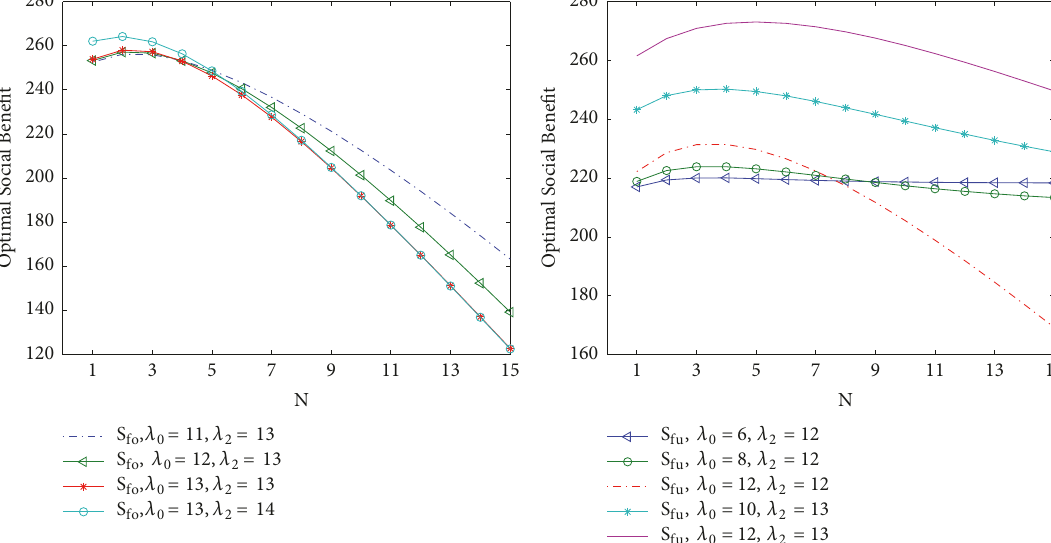
Figure 8: Left: optimal social benefit in observable case vs. 𝑁 for 𝑅 = 30, 𝐶 1 = 10, 𝐶 2 = 10, 𝜆 1 = 15. Right: optimal social benefit in the unobservable case vs. 𝑁 for 𝑅 = 30, 𝐶 1 = 10, 𝐶 2 = 10, 𝜆 1 =